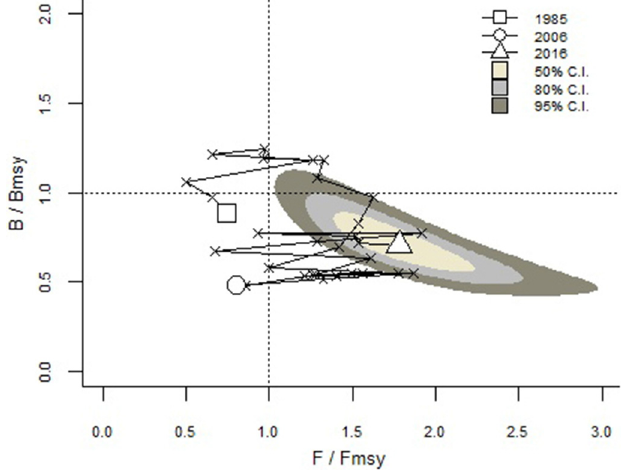
Fig. 11. Results of the BSM analyses relevant for management of S. undosquamis stock from the southeastern Arabain Sea. Figure shows the development of biomass and exploitation relative to B msy (horizontal dashed line) and F msy (vertical dashed line),